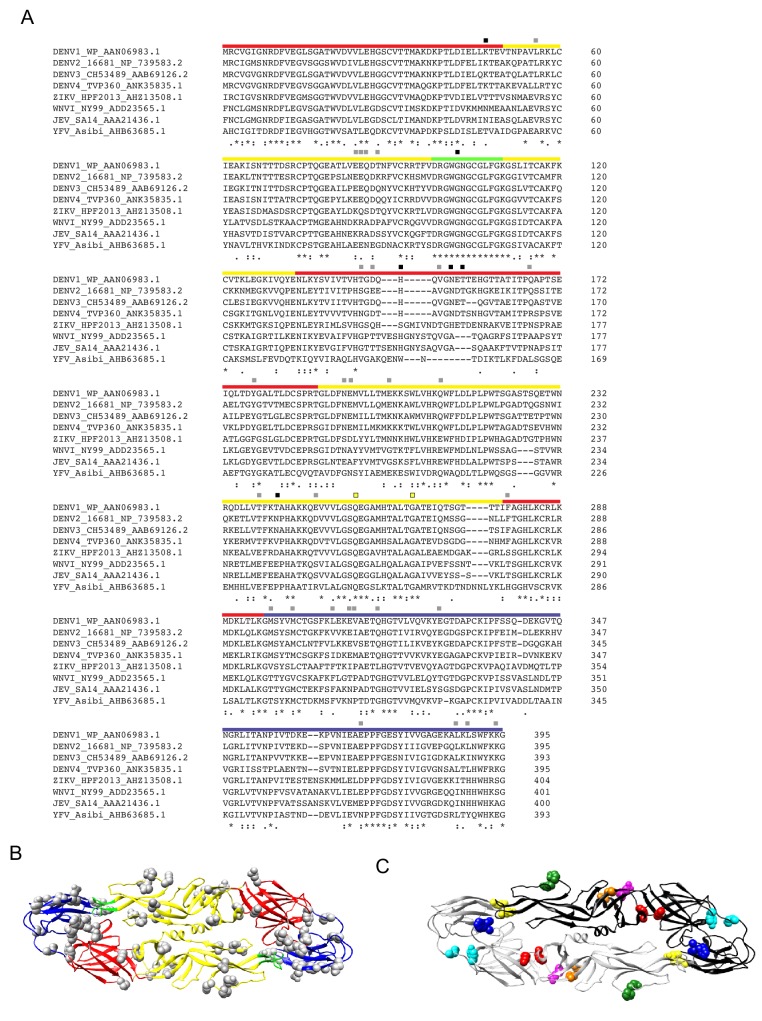
DENV2 E protein mutagenesis.(A) The E protein ectodomain residues of representative DENV1-4, ZIKV, and WNV, Japanese encephalitis virus (JEV), and Yellow Fever virus (YFV) strains were aligned using ClustalW2. Red, yellow, green, and blue bars above the alignment indicate residues within E protein DI, DII, DII fusion loop, and DIII, respectively. Squares above colored bars indicate residues selected for mutagenesis and generation of DENV2 reporter virus variants tested for sensitivity to J9 neutralization: gray squares = no effect on neutralization sensitivity; black squares = reduced sensitivity to J9 neutralization. Yellow squares indicate residues that are conserved across flaviviruses and are important for binding by antibody I7 in Figure 4B. The sequence used for ZIKV H/PF/2013 differs at two amino acids (residue 246 K > R and 345 M > I from GenBank accession number AHZ13508.1, as previously described; Dowd et al., 2016). (B) Ribbon structure of the DENV2 E dimer (PDB 1OAN) with 34 individually mutated residues shown as gray spheres. E protein domains are color-coded as in (A). (C) Ribbon structure of the DENV2 E dimer (PDB 1OAN) with one monomer shown in black, and the other in gray. Colored spheres indicate the locations of paired mutations: K47T+V151T (red); L56V+Q211E (orange); E85Q+Q86S (green); H149S+V151T (blue); Y178F+M287V (cyan); N194S+E195D (purple); Q316L+K394S (yellow). The effect of the indicated mutations in (B) and (C) on antibody neutralization potency is shown in Figure 5—figure supplement 3.